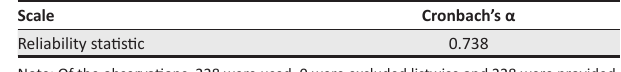
TABLE 6: Scale reliability statistics.